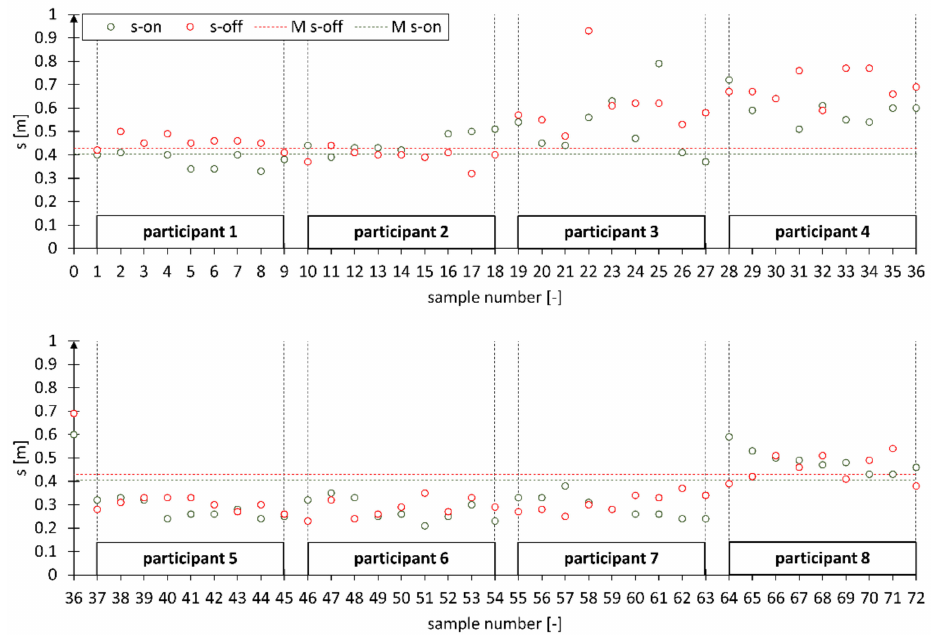
Figure 6. The diagram of the path distance in a single propelling cycle for all the analyzed measurement tests, where s-on—a path distance in a single propelling cycle with the activated anti-rollback system, s-o ff —a path distance in a single propelling cycle with the deactivated anti-rollback system, M s-on—an average road for all the measurement tests with the activated anti-rollback system, M s-o ff —an average road for all the measurement tests with the deactivated anti-rollback